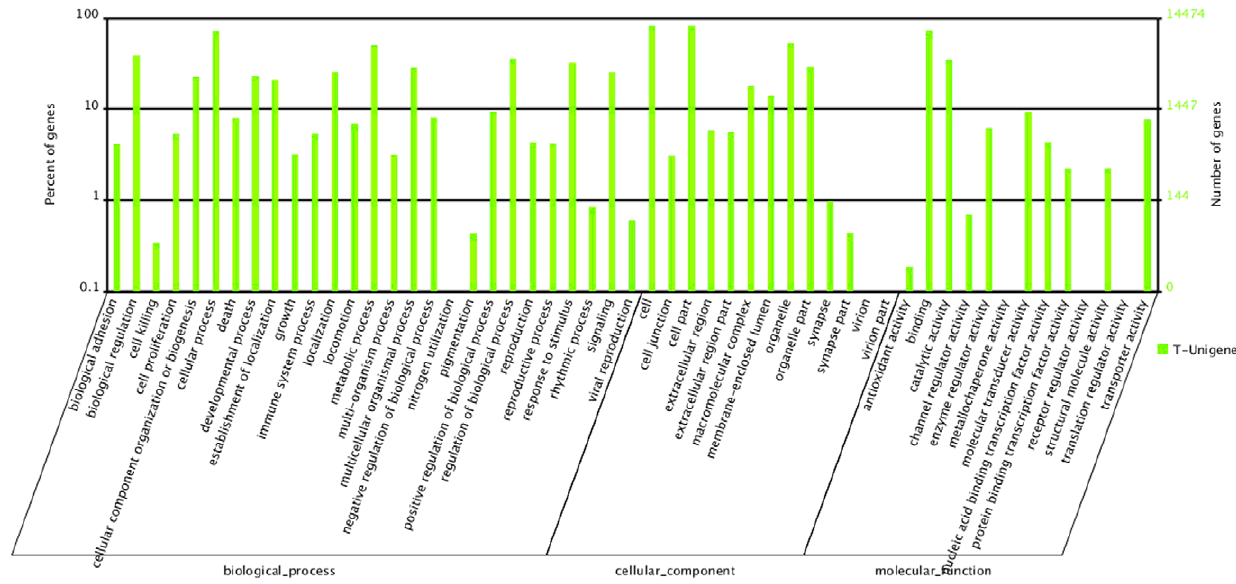
Figure 4. Histogram presentation of Gene Ontology classification. The results are summarized in three main categories: biological process, cellular component and molecular function. The y-axis on the right indicates the number of genes in a category. The y-axis on the left indicates the percentage of a specific category of genes in that main category.